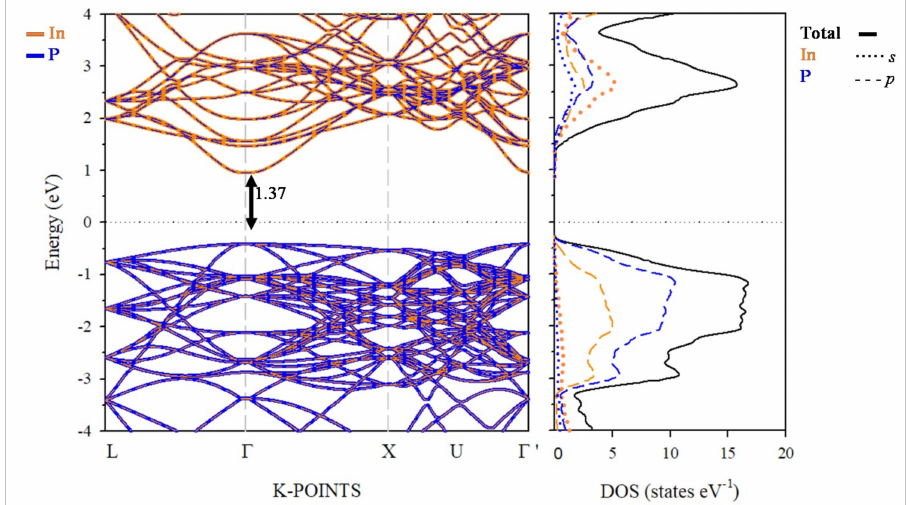
Figure 4. Projected electronic band structure (left) and density of states (DOS) (right) of InP calculated within PBE + U ( U e ff = 15 eV) approach, along with main energy di ff erences at Γ -point. The zero energy was set at the Fermi level (black dotted line). The spin-up and spin-down bands and DOS are not given separately, as both contributions were the same for the native InP